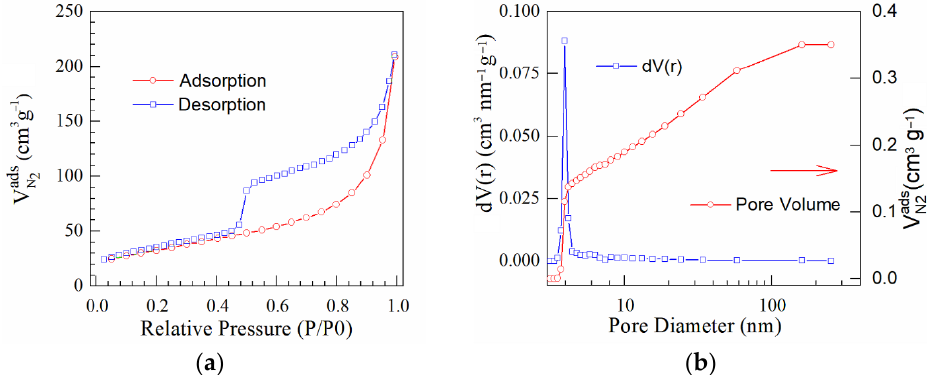
Figure 9. ( a ) N 2 adsorption–desorption isotherms and ( b ) BJH curves corresponding to